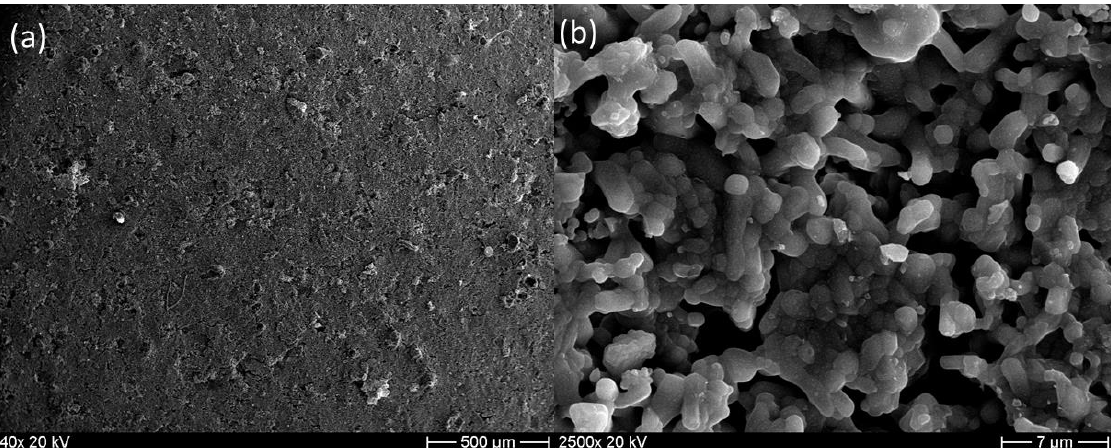
Figure 8. SEM images of the phosphate ceramic support ( a ) surface and ( b ) cross-section view.